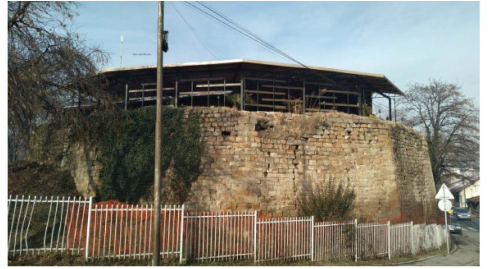
Figure 6. Southern Tabia: SW-NW view (Photo source: Lejla Ze´cirovi´c).